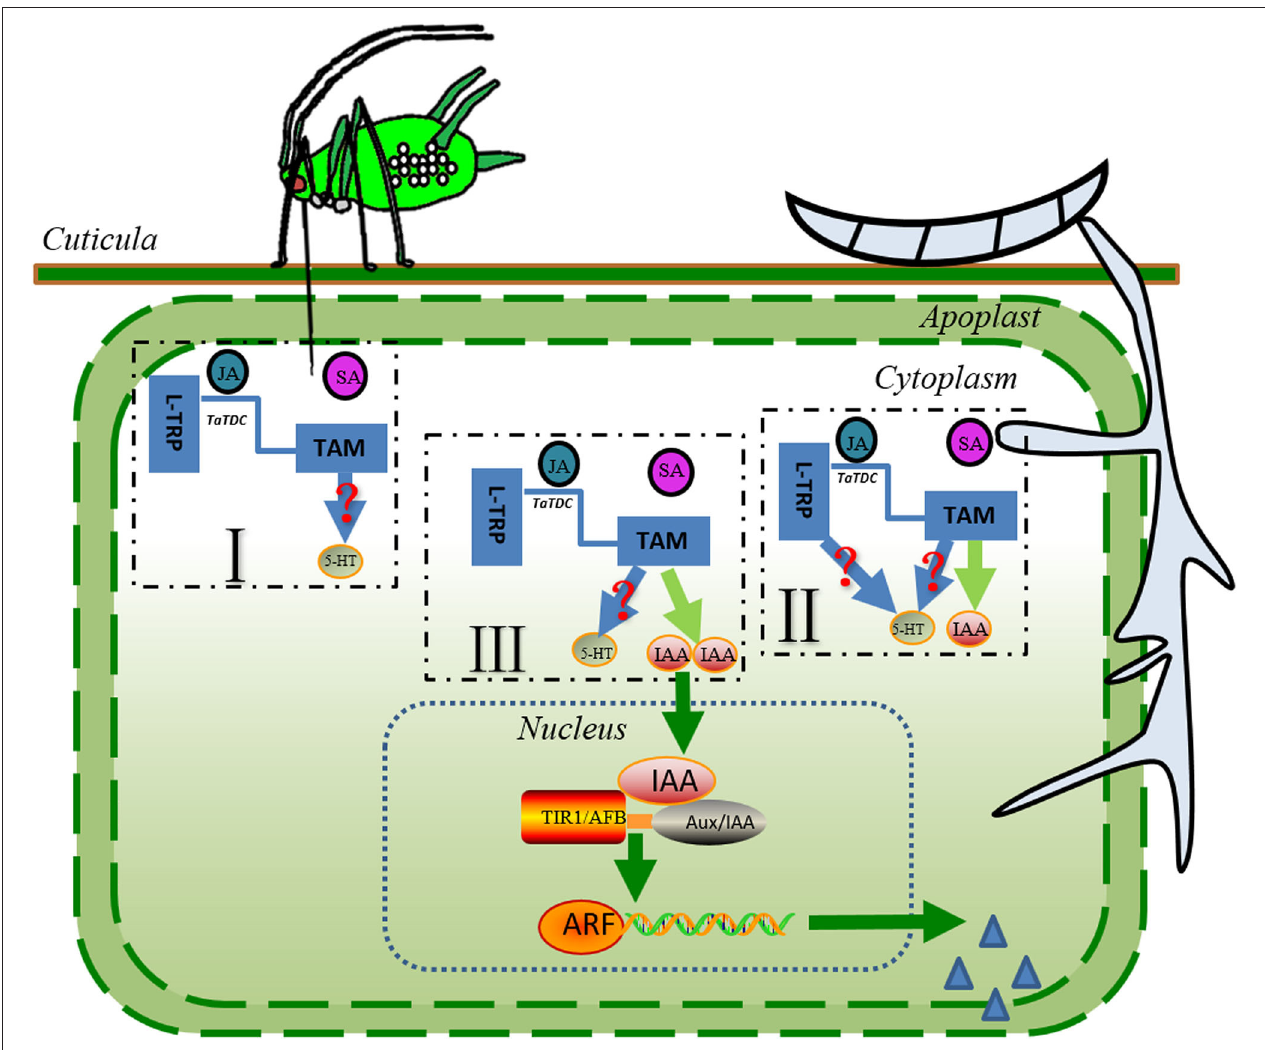
FIGURE 2 | The potential pathways of L-TRP catabolism during sequential infestation with S. avenae and F. graminearum . The sequential colonization of S. avenae and F. graminearum induces the JA-mediated defense signaling, which may result in a higher level of expression of the TaTDC gene and the accumulation of TAM in wheat seedlings. TAMs can be converted into serotonin (5-HT) or (and) IAA after S. avenae infestation and F. graminearum infection. Auxins may promote the rapid release of more plant nutrients; in addition, they may increase the opportunity for pathogen penetration and colonization, possibly because auxin can weaken the plant cell wall. Blue solid lines and light green lines represent the potential pathways of L-TRP catabolism. Green lines and arrows indicate the pathways for IAA signaling. Steel blue triangles depict the plant cell wall-degrading enzymes secreted by F. graminearum . Red question marks represent the pathways predicted from the literature. L-TRP, L- tryptophan; JA, jasmonic acid; IAA, indole-3-acetic acid; TaCDC , wheat tryptophan decarboxylases; ARF, auxin response factor; AUX/IAA, auxin/indole-3-acetic acid.